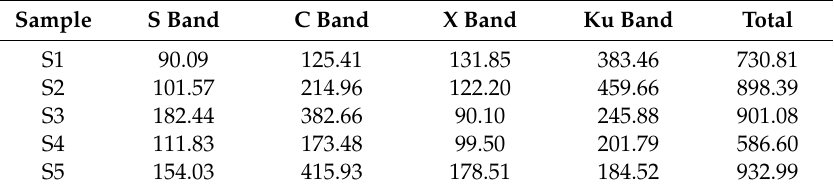
Figure 6. Attenuation coe ffi cient contour map of Fe 3 O 4 samples in the range of 2–18 GHz. Table 3. Integral values of attenuation coe ffi cients of Fe 3 O 4 samples at di ff erent